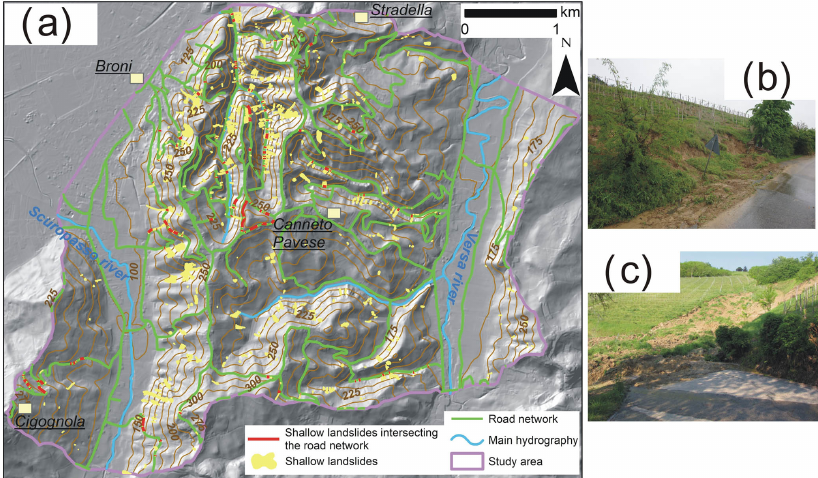
Figure 3. (a) Primary road network of the study area, with the shallow landslides events that occurred between 2009 and 2014 that affected these routes. This road network is composed of provincial and municipal roads (available from: Administration of Pavia Province and Infrastructure for Spatial Information in Lombardy (Lombardy Region geoportal: http://www.cartografia.regione.lombardia.it/geoportale, last access: 11 December 2017). (b) A shallow landslide (B2 type), triggered in correspondence of the road trench upstream of the route, that blocked the route. (c) A shallow landslide triggered in a slope cultivated with vineyards, whose mobilized materials destroyed completely a road trait